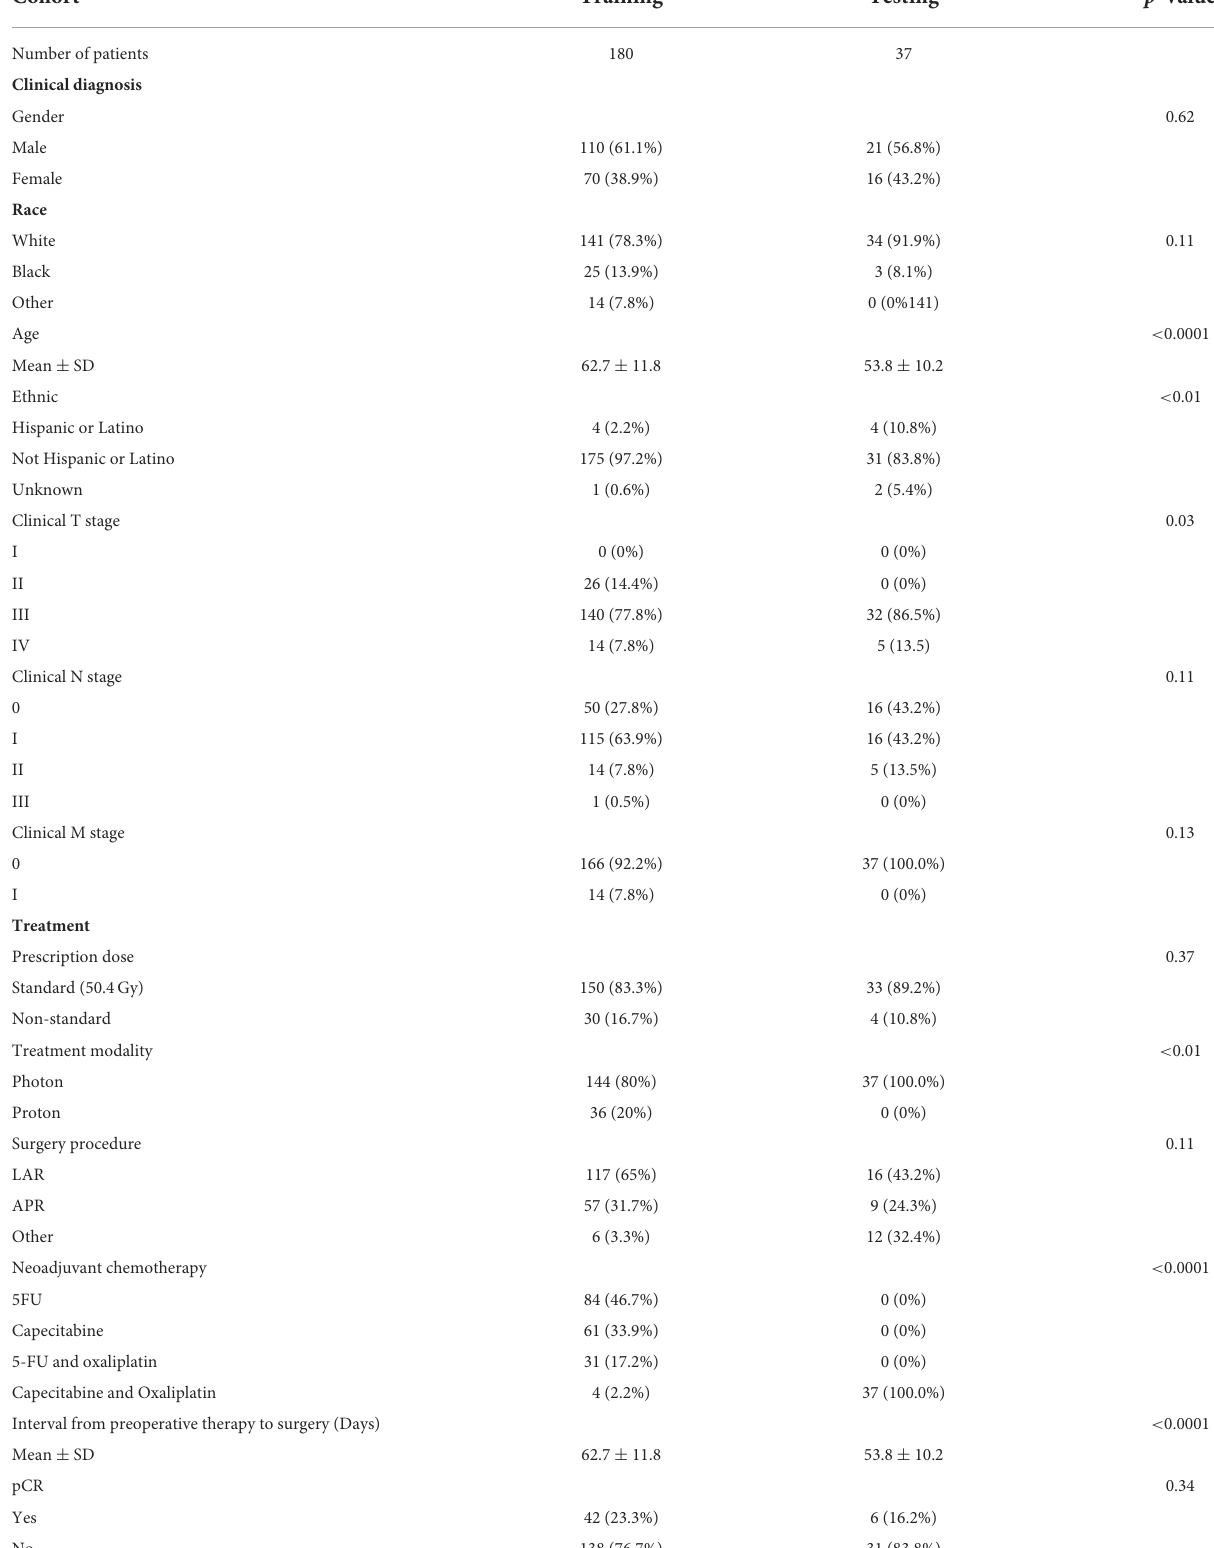
TABLE 1 Clinical and demographic characteristics of enrolled